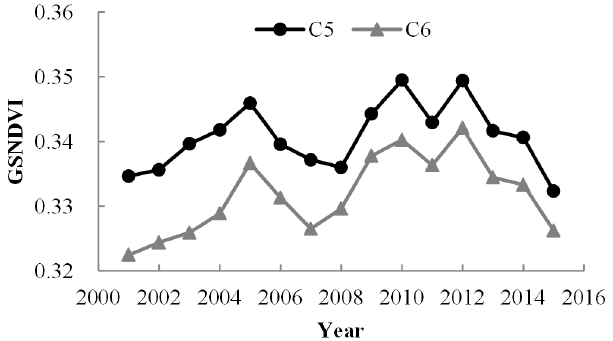
Figure 1. Comparison of annual regional average growing season Normalized Difference Vegetation Index derived from MODIS C5 (GSNDVI C5 ) and C6 (GSNDVI C6 ) for the alpine grassland on the Tibetan Plateau during 2001–2015.